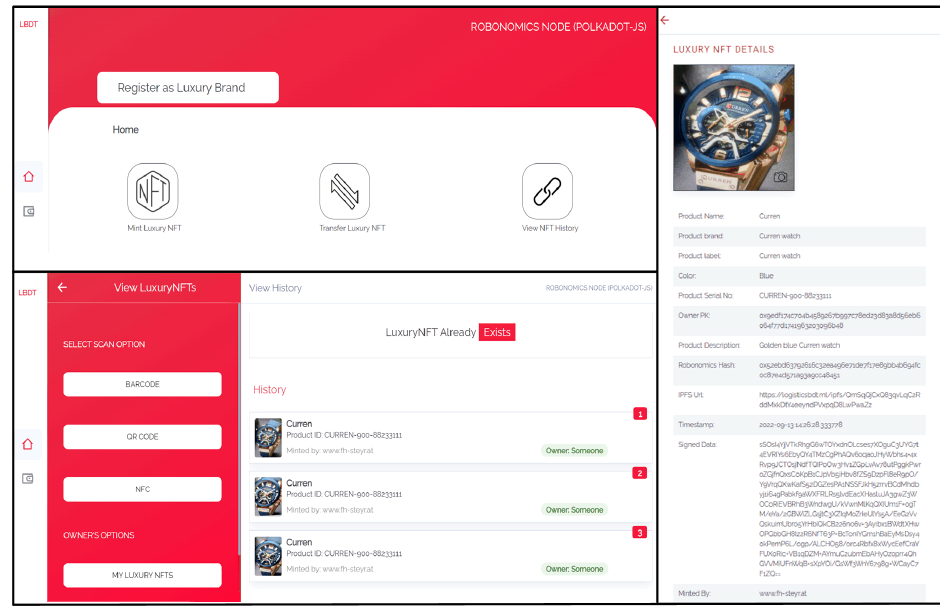
Figure 5. App home interface, the ownership history of a luxury NFT and metadata.